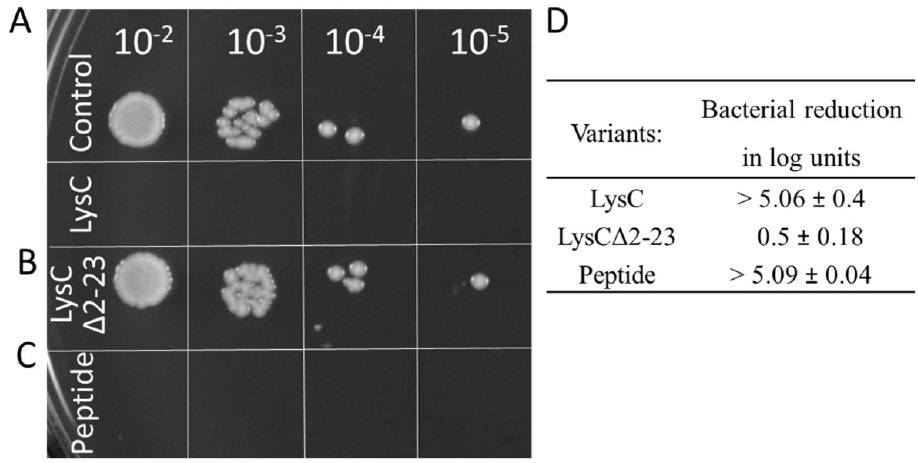
Figure 8. Antimicrobial activity of LysC ∆ 2–23 and the Intestinalin peptide against S. aureus ATCC 25923. Antibacterial test with LysC served as a positive control. Drops in a volume of 5 µ L, containing serial 10-fold dilutions of ( A ) control samples and samples with LysC, ( B ) LysC ∆ 2–23 and ( C ) 30 aa peptides (Intestinalin), respectively, were spotted onto TSB agar. Plates were incubated overnight, and then photographed; (D) Antibacterial activities are expressed as bacterial reduction in logarithmic units relative to the untreated control (average from three replicate measurements ± standard deviation).